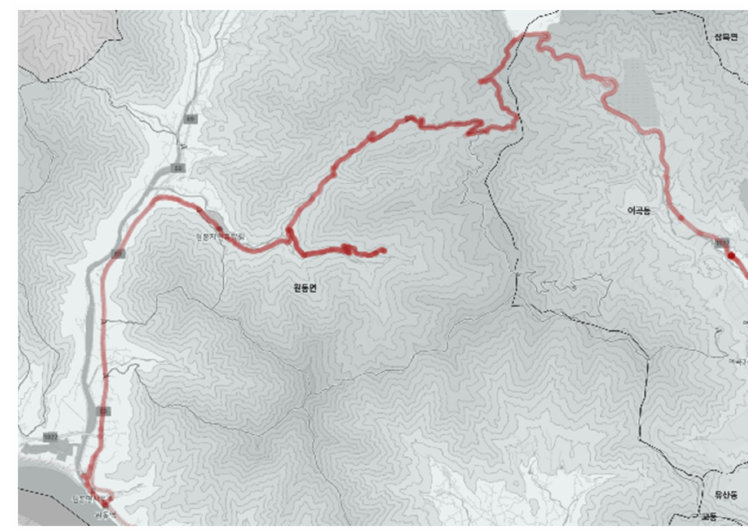
Figure 10. Actual driving record of city-type bus No. 1.